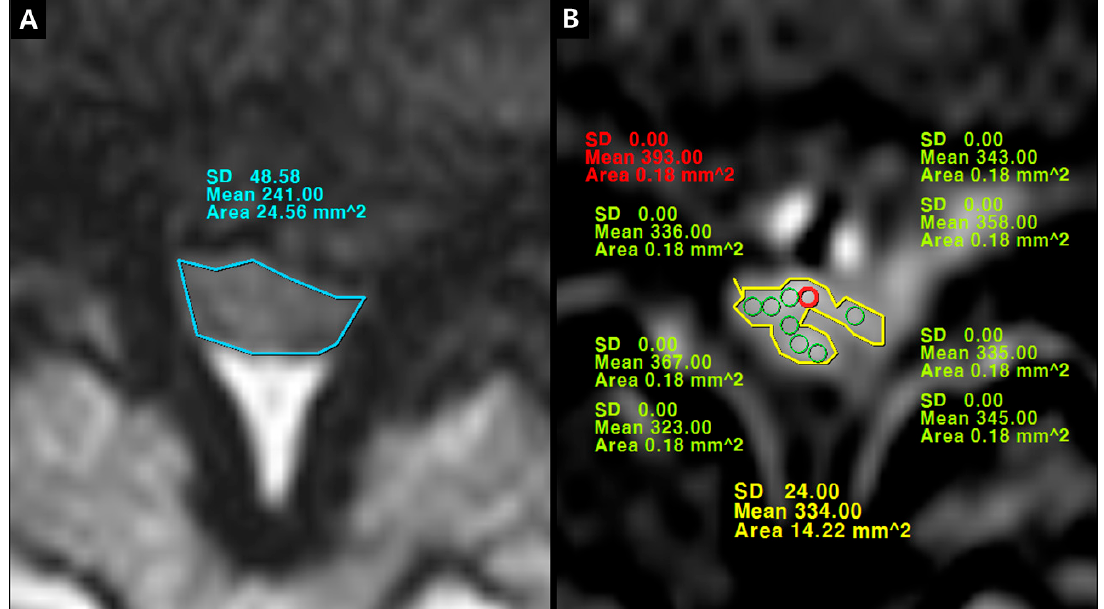
Figure 6. (A ) dural cross sectional area (DCSA) on T2-weighted axial image; ( B ) whole rootlets IRCE (WR-IRCE, yellow color) and maximal spot rootlet IRCE (MS-IRCE, red color) on fat-suppressed enhanced T1-weighted axial image among signal intensities of manually-defined whole rootlets and each rootlet.